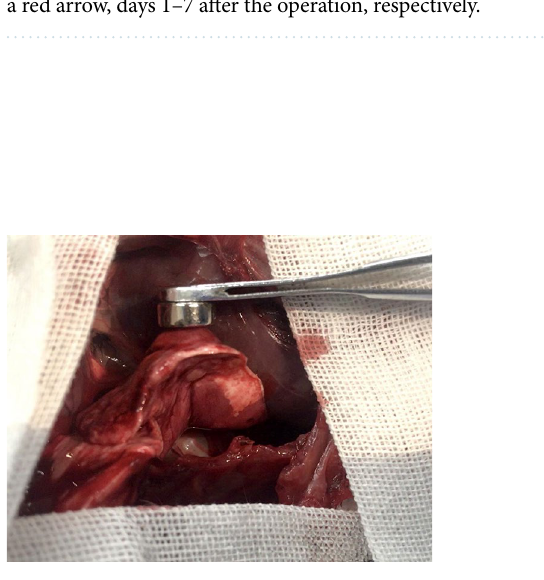
Figure 9. ( a – g ) Long-term localization of the magnetic gel in lung tissue, viewed under X-ray, are indicated by a red arrow, days 1–7 after the operation, respectively.